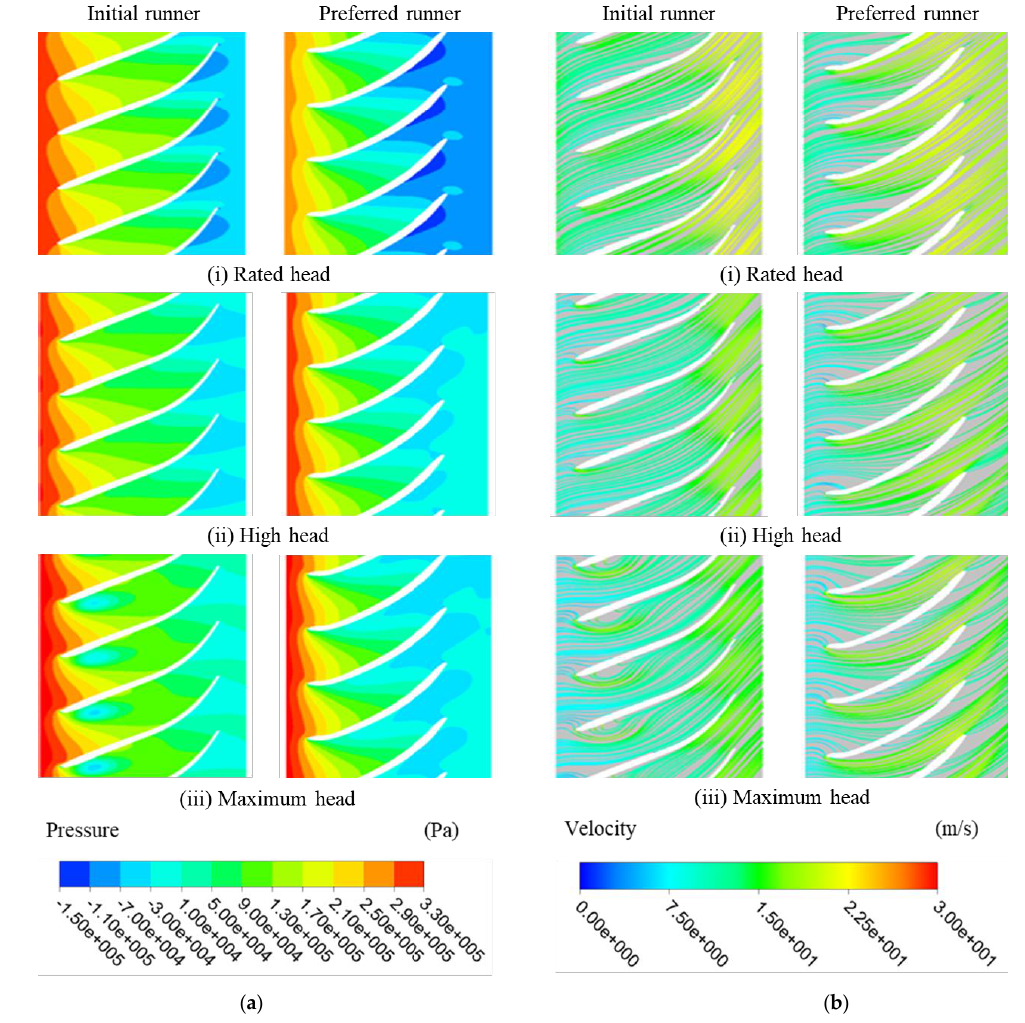
Figure 13. Flow conditions on the middle span surface for initial and preferred runners. ( a ) Pressure contours; ( b ) Surface streamlines.